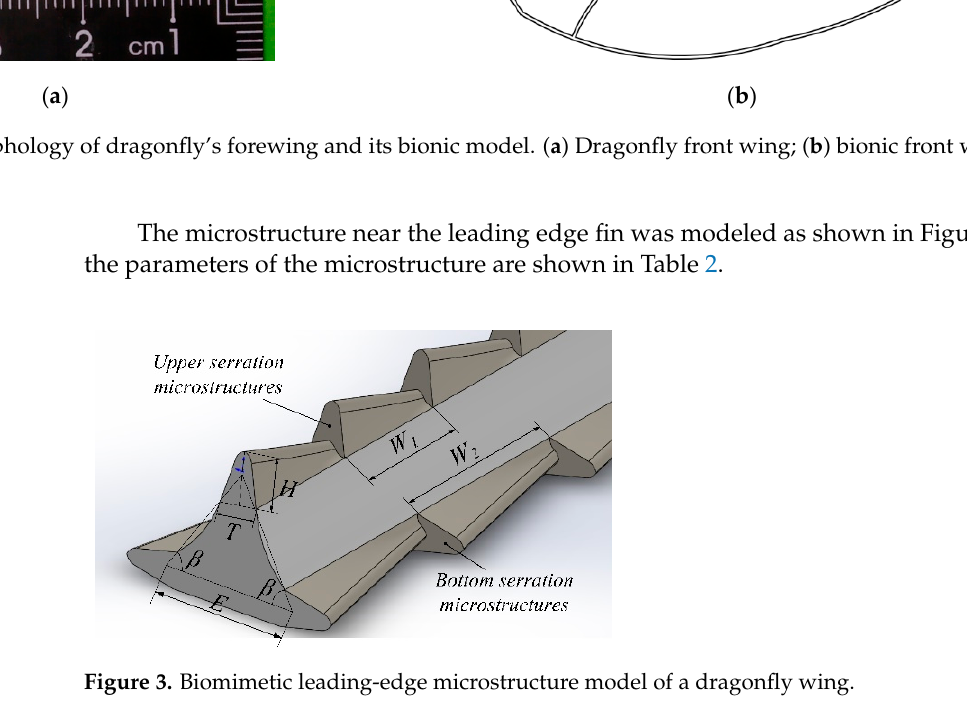
Figure 2. The morphology of dragonfly’s forewing and its bionic model. ( a ) Dragonfly front wing; ( b ) bionic front wing model and size.